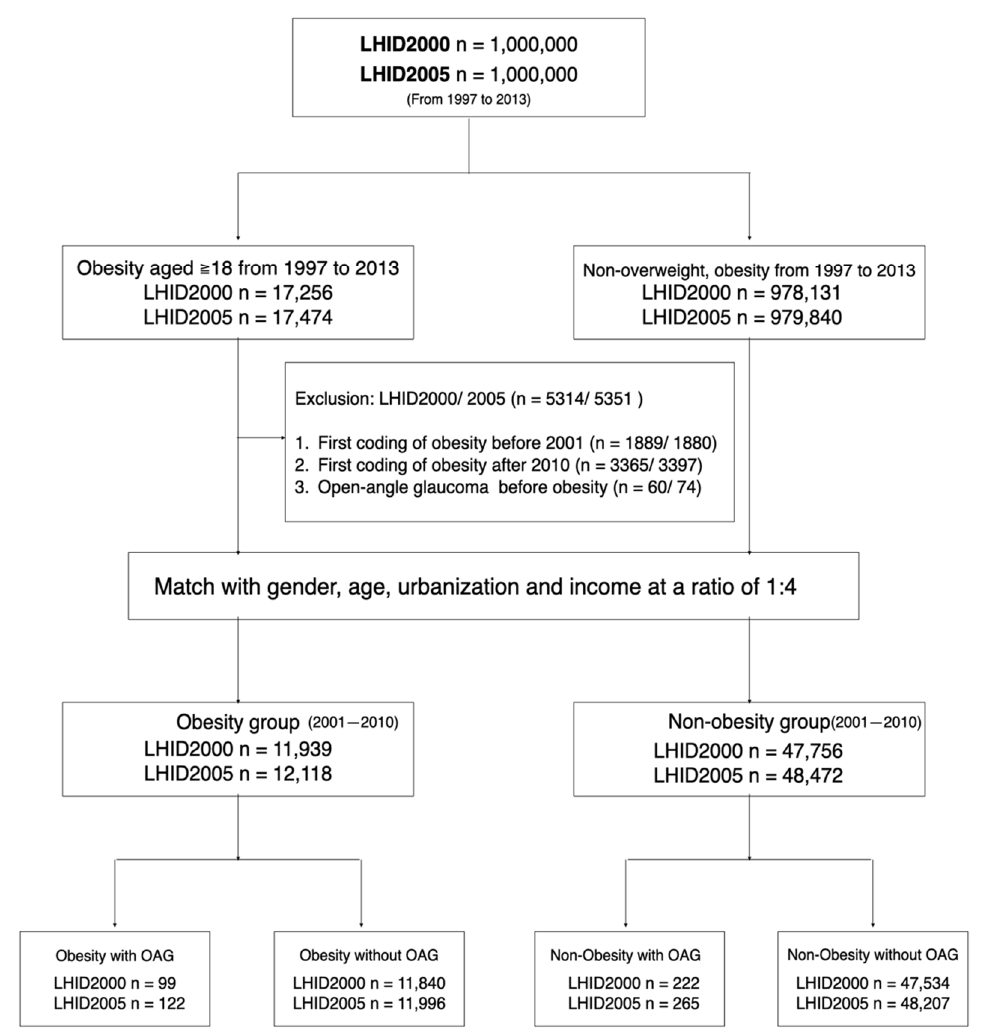
Figure 1. Flowchart of enrollment and allocation of adults with obesity and non-obesity in a two-database matched-cohort study. Obese adults aged ≥ 18 years in the LHID2000 and LHID2005 between 1 January 1997 and 31 December 2013 were included. Adults first diagnosed with obesity before 2001, adults first diagnosed with obesity after 2010, and adults diagnosed with OAG before obesity were excluded in this study. Obese adults were matched with non-obese adults at a 1:4 ratio by sex, age, urbanization level, and income. All adults were traced until the death, occurrence of OAG, or 31 December 2013. LHID = longitudinal health insurance database; OAG = open-angle glaucoma